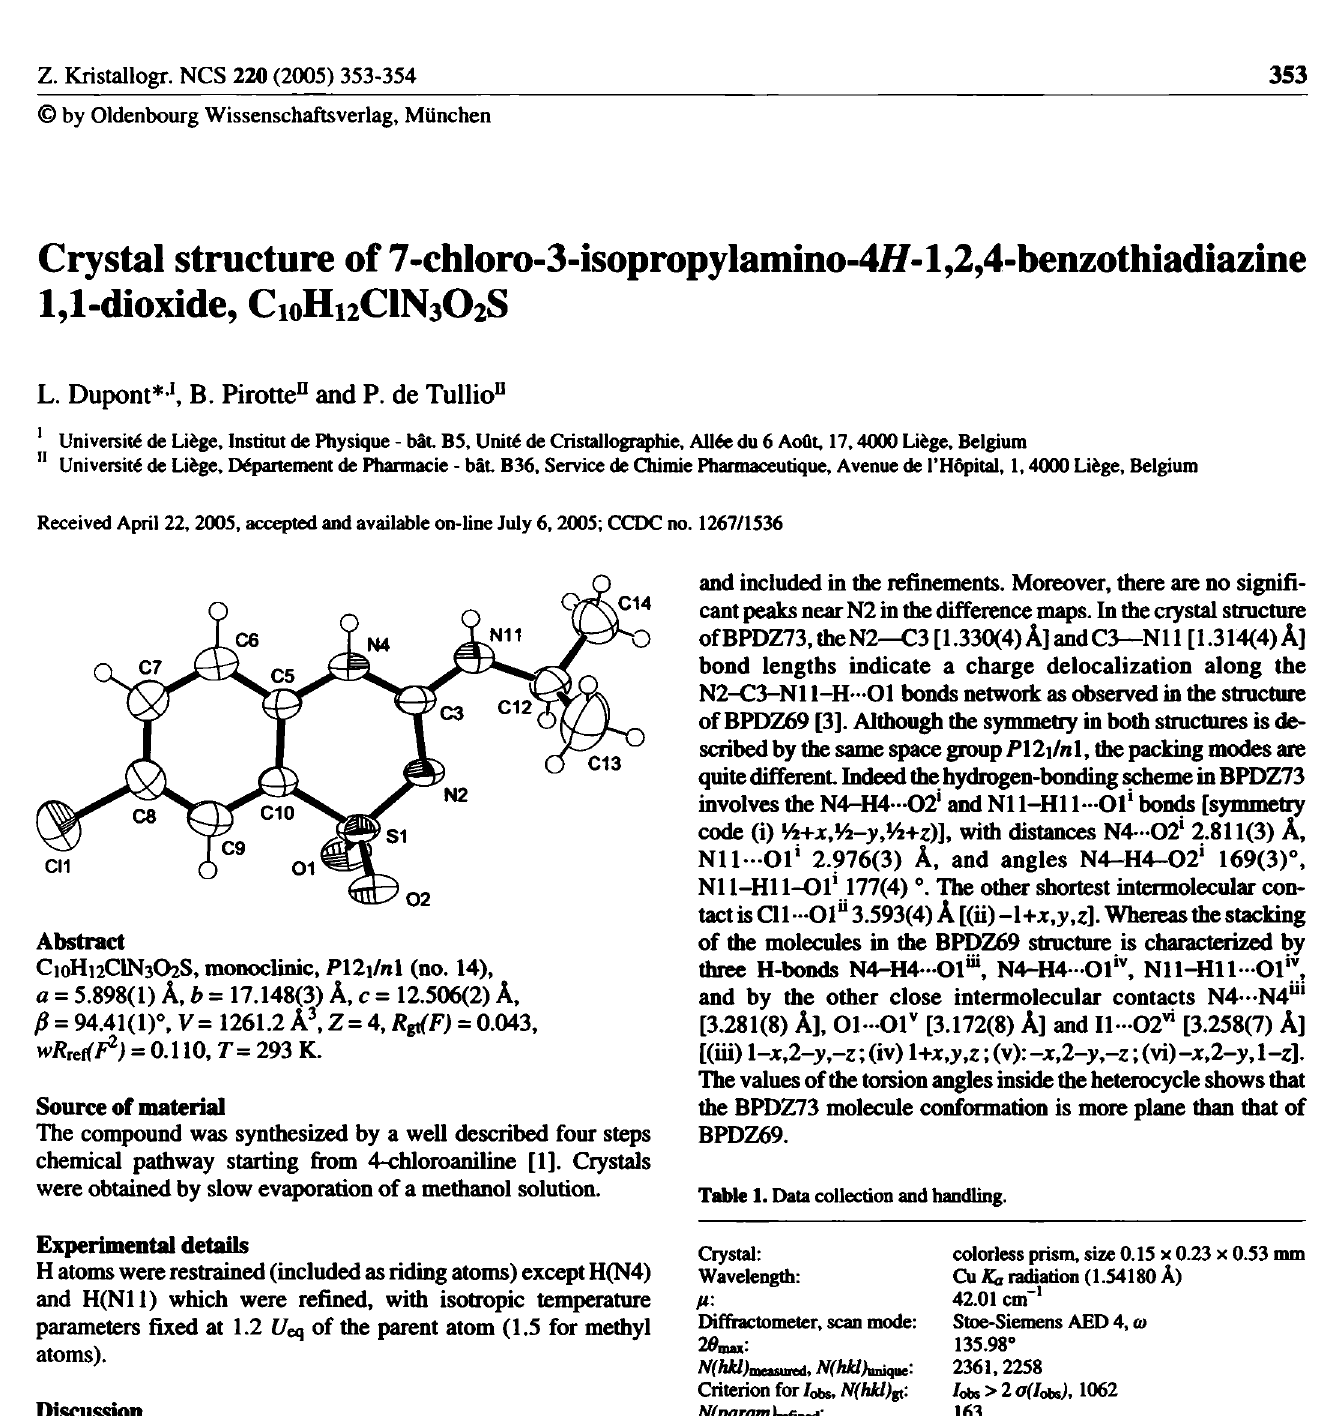
Table 1. Data collection and handling.